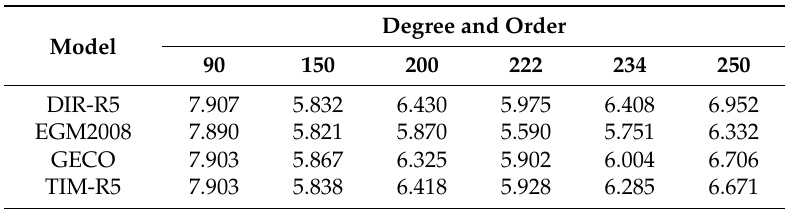
Figure 3. Comparison between filtered gravity anomalies and GGM anomalies in mGal. Each row represents a degree and order (d/o) of expansion, where row 1 (panels a – d ) shows the values for d/o 90, row 2 (panels e – h ) shows the values for d/o 150, row 3 (panels i – l ) shows the values for d/o 200, row 4 (panels m – p ) shows the values for d/o 222, row 5 (panels q – t ) shows the values for d/o 234, and row 6 (panels u – x ) shows the values for d/o 250. The columns represent the tested models arranged from left to right as DIR-R5, EGM2008, GECO, and TIM-R5, respectively. Table 1. Standard deviation of the smoothing process